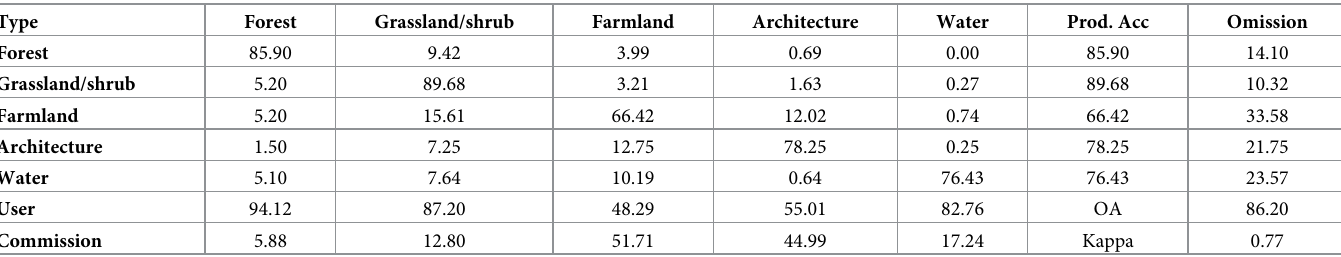
Table 4. Accuracy of the object-oriented classification of Baili